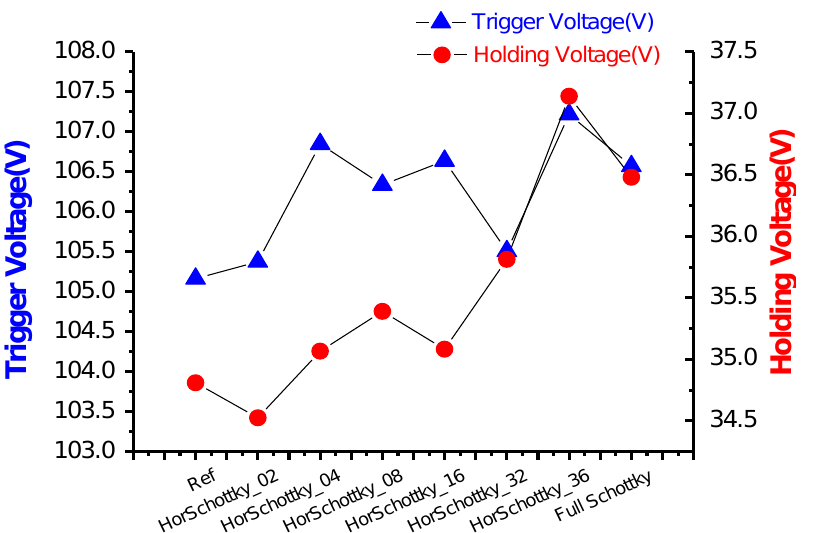
Figure 5. Snapback I-V curves and leakage currents of HV nLDMOSs with the drain elec- trode-embedded horizontal Schottky rows modulation.